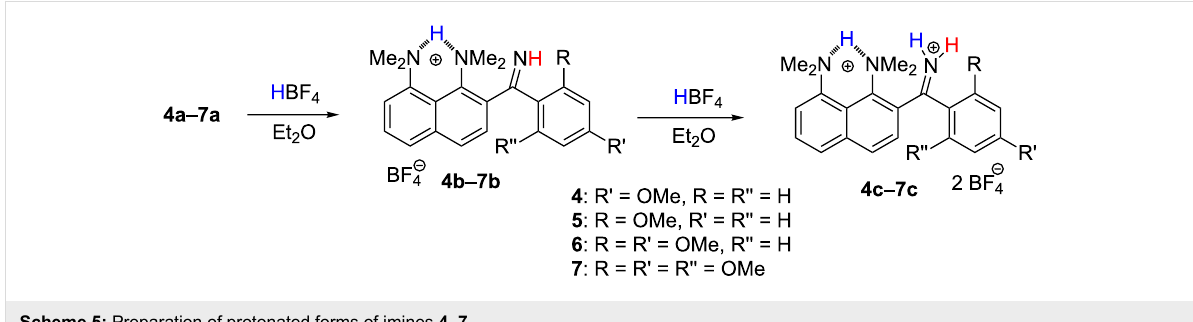
Scheme 5: Preparation of protonated forms of imines 4 – 7 .